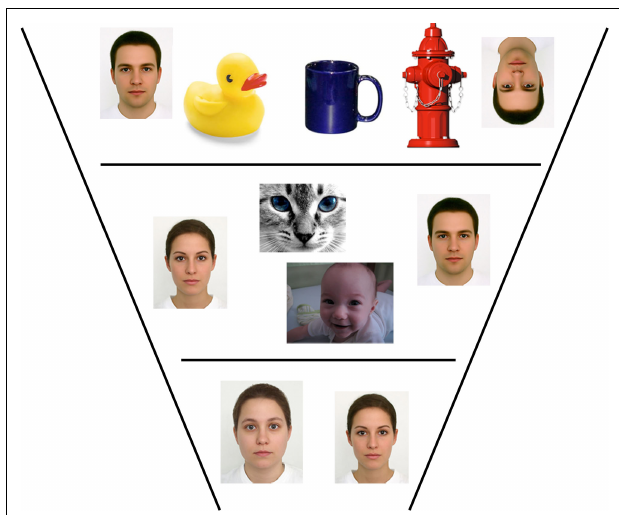
FIGURE 1 | A Hierarchical ontology for face categories. A schematic view of multiple levels of face specifi city. At the broadest level on top of this diagram, faces may only be differentiated from non-faces. Continuing downwards, faces are grouped by categories like race and species, ultimately grouped within those categories by individual identity. The goal of the current study is to determine how these varying levels of specifi city affect one another in terms of the neural response to